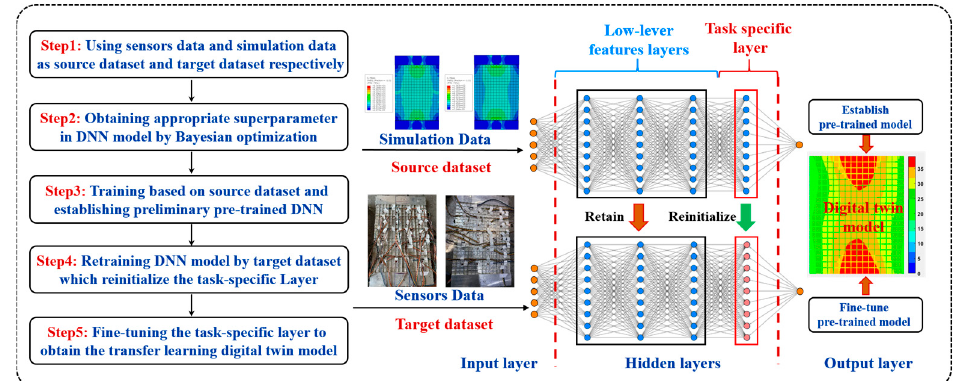
Figure 2. Digital twin modeling method based on transfer